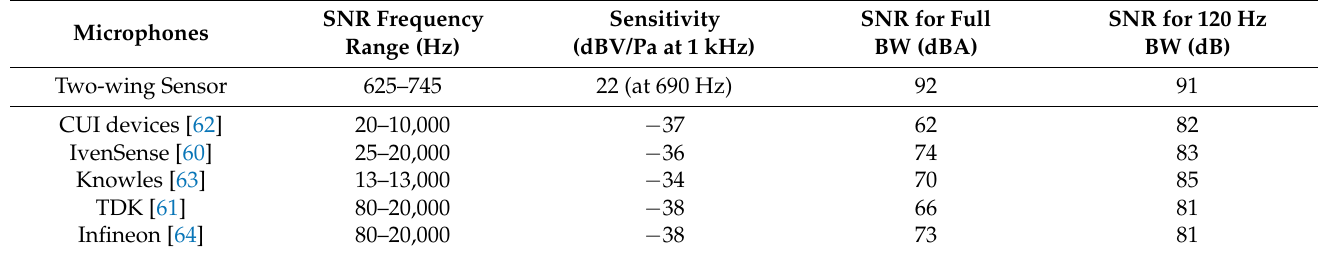
Table 1. Sensitivity and signal-to-noise ratio of state-of-the-art commercial MEMS microphones with analog output, including the sensor reported in this paper, for